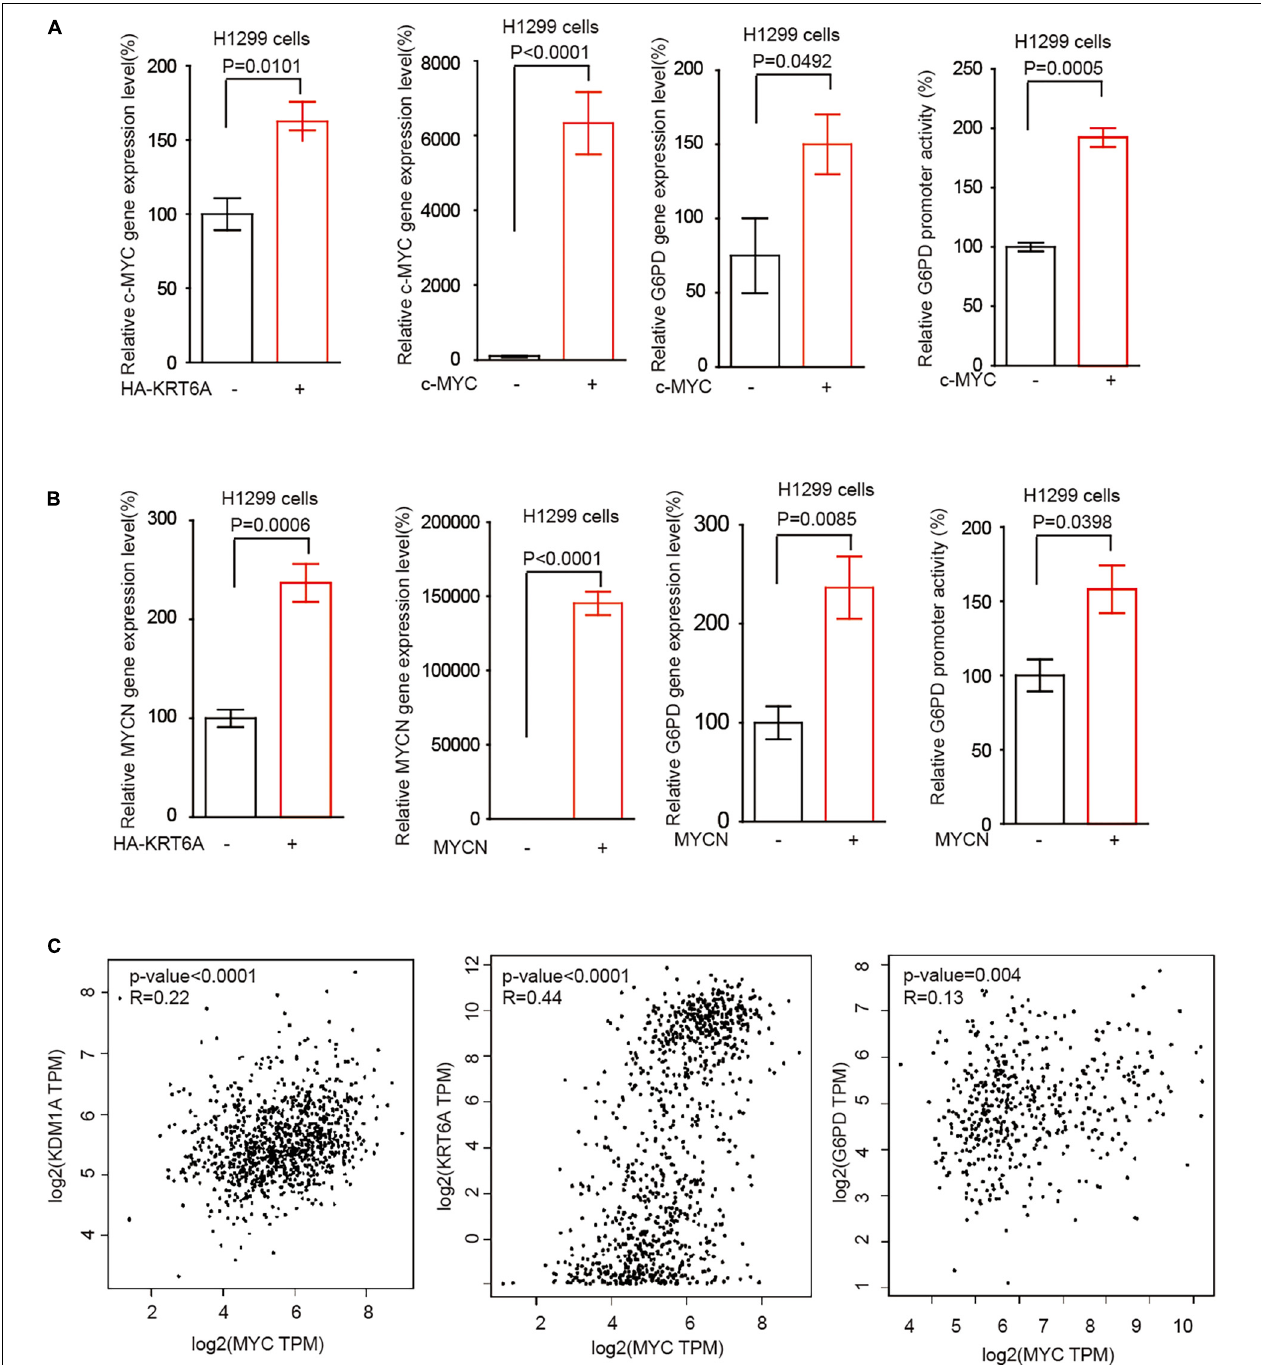
FIGURE 6 | KRT6A promotes G6PD expression through upregulation of c-MYC and MYCN. (A) Determination of c-MYC mRNA expression levels by Real-time PCR (left) in KRT6A overexpressing and control H1299 cells. The G6PD mRNA expression level and G6PD promoter activity (right) in c-MYC overexpressing and control H1299 cells. (B) The MYCN mRNA expression levels by Real-time PCR (left) in KRT6A overexpressing and control H1299 cells. The G6PD mRNA expression level and G6PD promoter activity (right) in MYCN overexpressing and control H1299 cells. (C) Correlation of c-MYC with LSD1 (KDM1A), KRT6A and G6PD expression in NSCLC tumor tissues, calculated from http://gepia.cancer-pku.cn/.